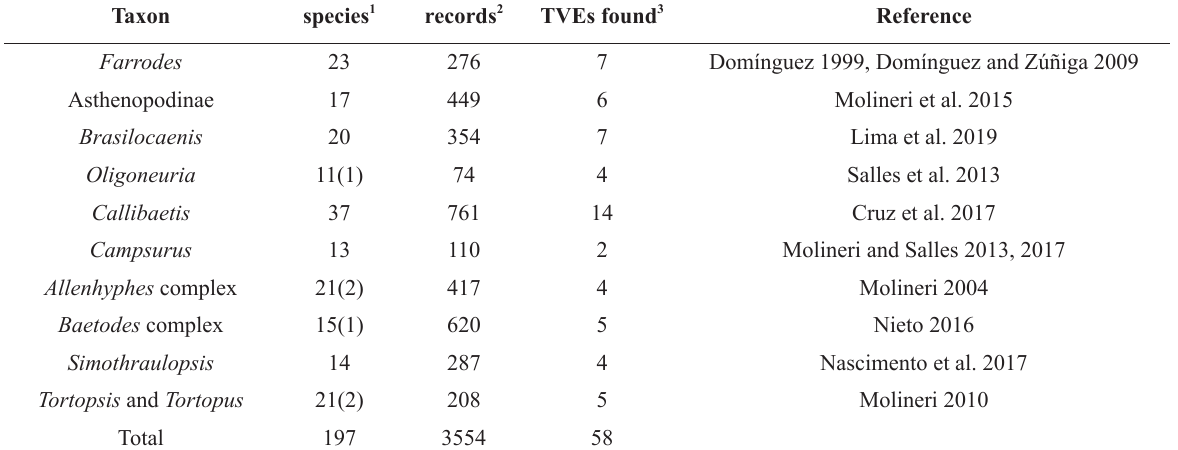
Data included in this study. 1 = number of species included in the original phylogeny, and number of species newly here incorporated (in brackets), 2 = total number of geographical records, 3 = number of TVEs found by